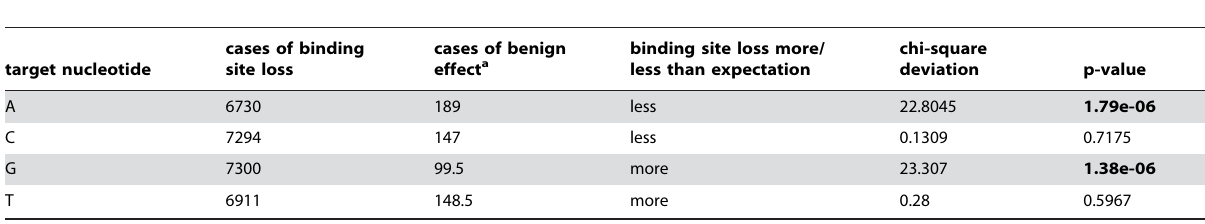
Table 4. Comparison of the distributions of substitution types among cases of binding site loss and those of benign effect, pooling together substitution types with the same target